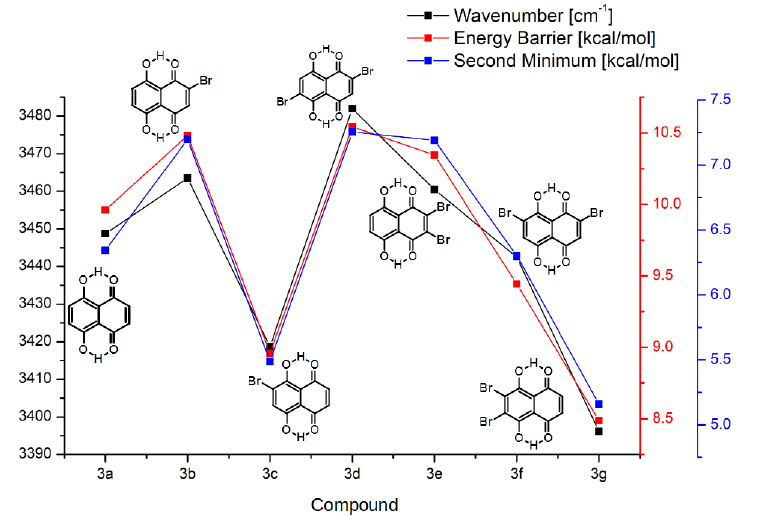
Figure 6. The ν OH stretching wavenumber, energy barrier and the second minimum energy values in group 3 of the studied